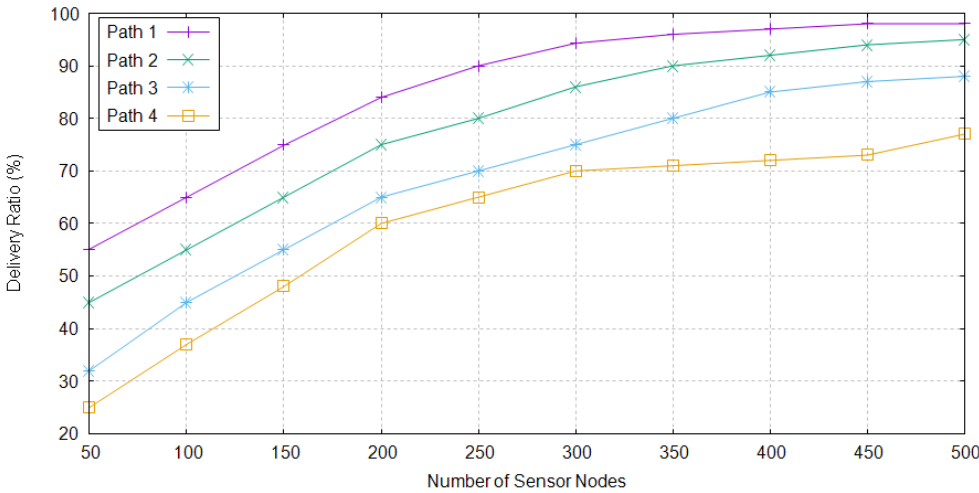
Figure 8. Packet Delivery Ratio of Different Paths in TBRL.